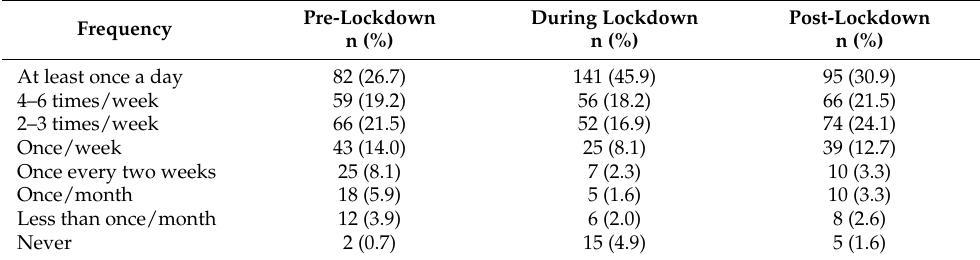
Table 1. Frequency respondents reported going for walks before, during, and after lockdown.